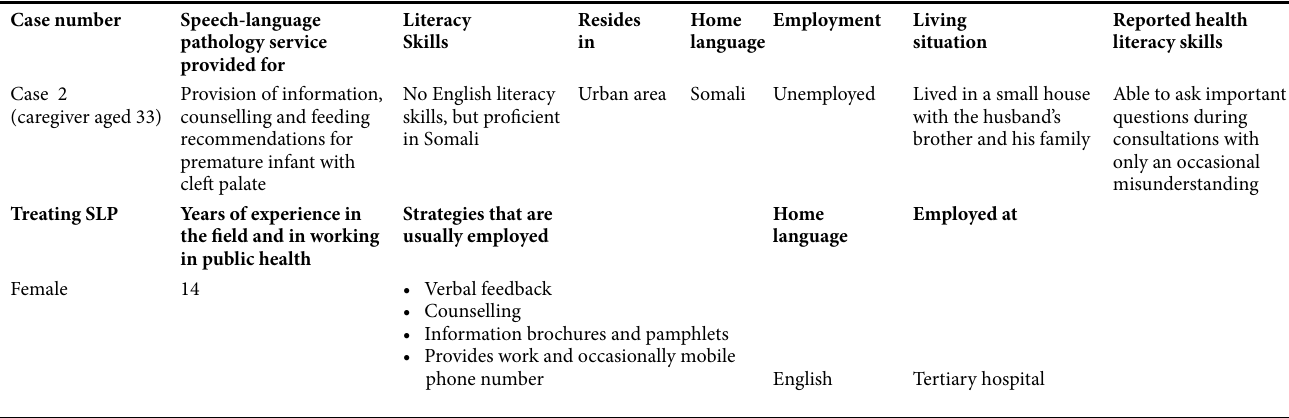
Table III. Case study